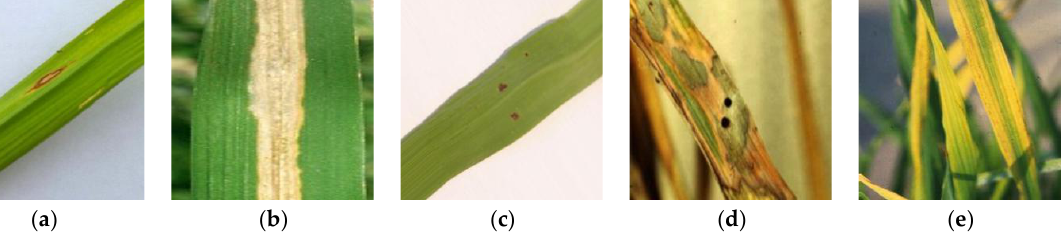
Figure 6. Images of rice disease: ( a ) rice blast; ( b ) blight; ( c ) brownspot; ( d ) sheath blight; and ( e ) tungro.